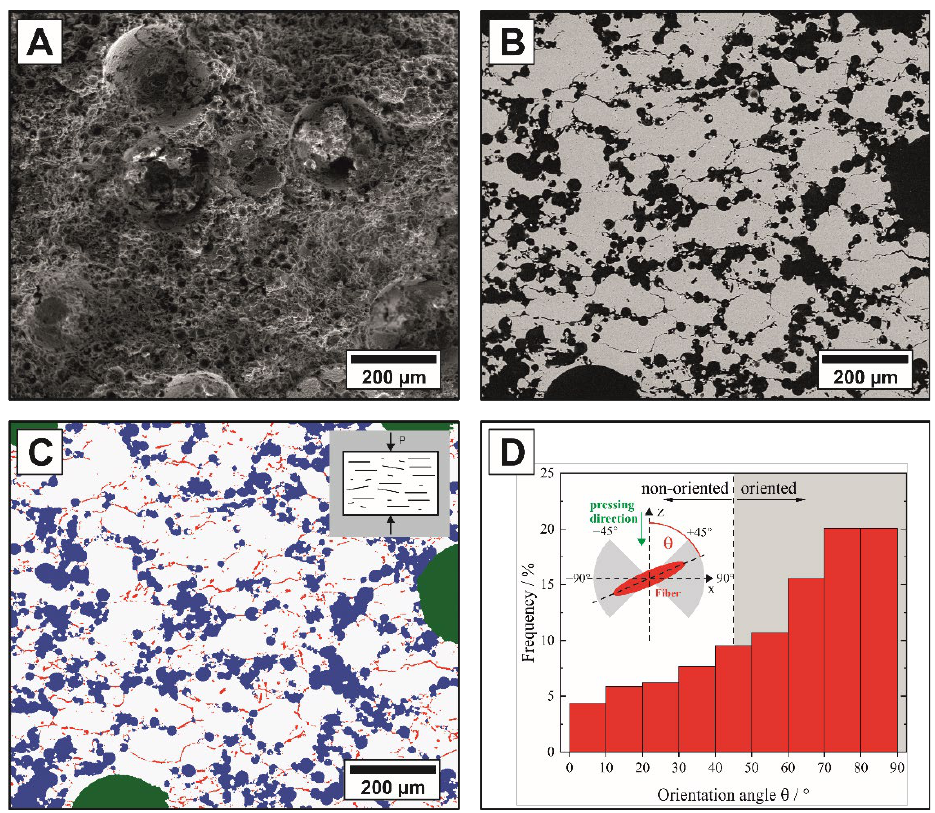
Figure 4. Microstructure of a trimodal sample: SEM micrographs of the fracture surface ( A ) and polished cross-section ( B ) of an alumina ceramic with a trimodal distribution of sacrificial templates (batch No. 13); ( C ) shows the false-color image of the polished cross-section highlighting the interconnected pore network in red (pyrolyzed cellulose fibers), blue (30 µm phenolic resin spheres), and green (300 µm phenolic resin spheres). ( D ) shows the 2D analysis of the fibrous pore orientation represented by the corresponding angular distribution.